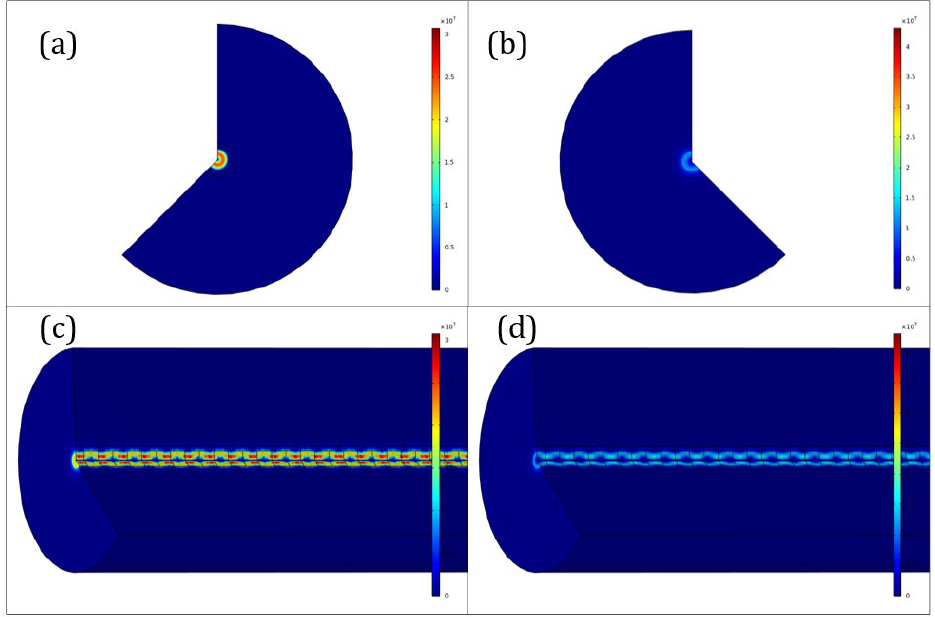
Figure 4. The distribution of 3D-simulated electric field in ( a ) x–y and ( c ) y–z cross-sections with low reflection and in ( b ) x–y and ( d ) y–z cross-sections with high reflection at the fiber end.